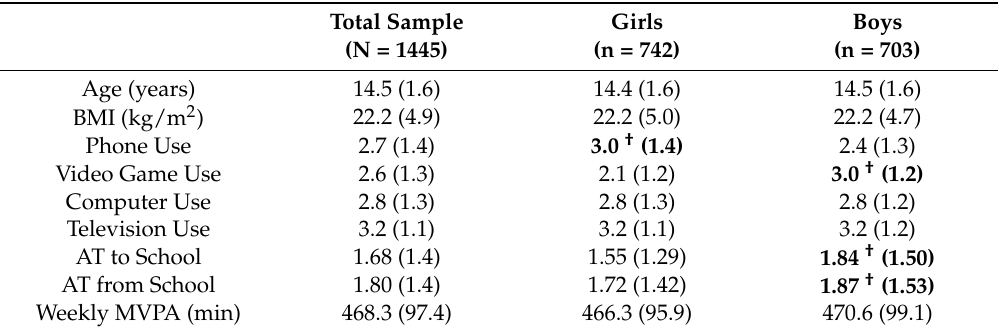
Table 1. Descriptive statistics for the total sample and within sex groups (means and standard deviations).